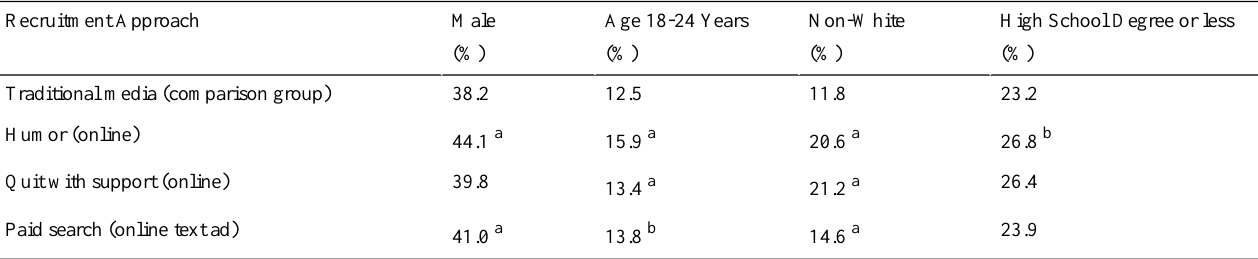
Table 3. Demographic characteristics of individuals recruited to cessation treatment by recruitment